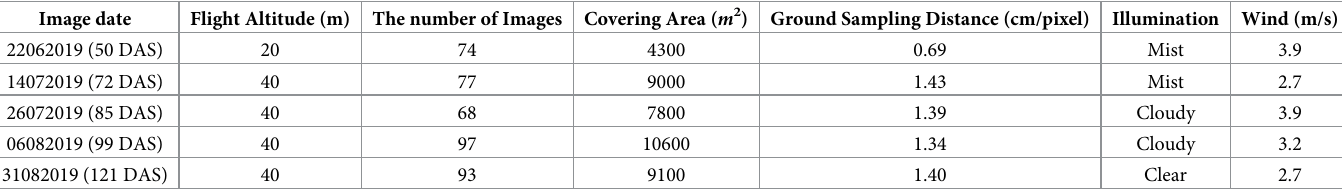
Table 1. UAV aerial images acquisition during growing seasons (June to